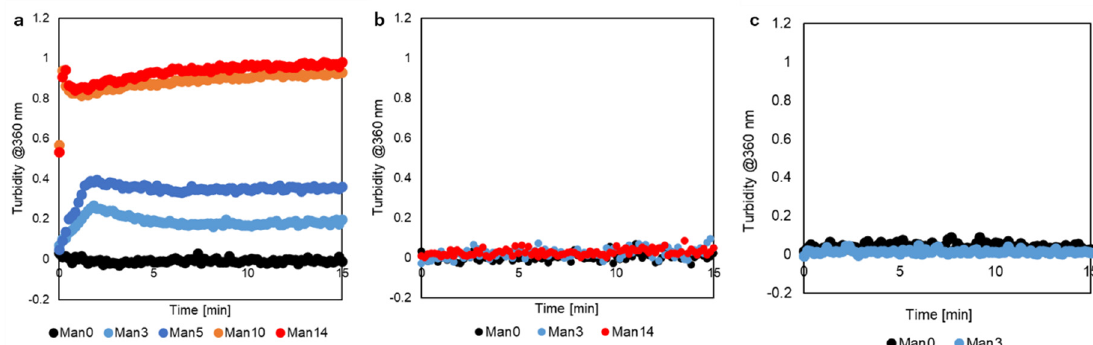
Figure 3. Turbidity change at 360 nm of curdlan derivative-modified liposome suspension in the presence of Con A ( a ), Con A and free mannose ( b ) and BSA ( c ).